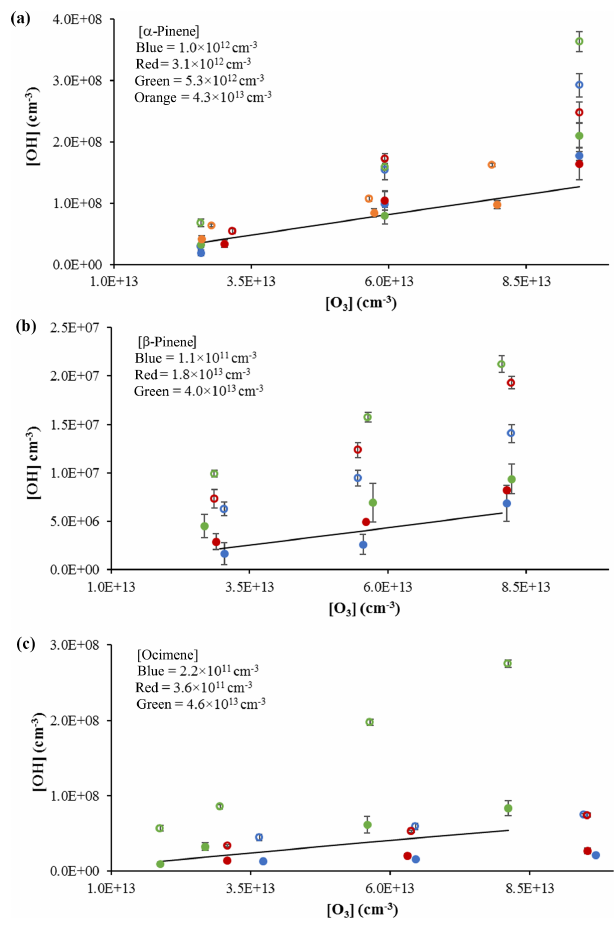
Figure 4. OH concentrations using the short inlet from the ozonol- ysis of α -pinene (a) , β -pinene (b) , and ocimene (c) . Open circles indicate measurements with the interference; filled circles indicate measurements without the interference. Colors indicate estimated concentrations. Solid lines reflect the expected OH radical yield (see text). Error bars reflect the measurement precision (1 σ)